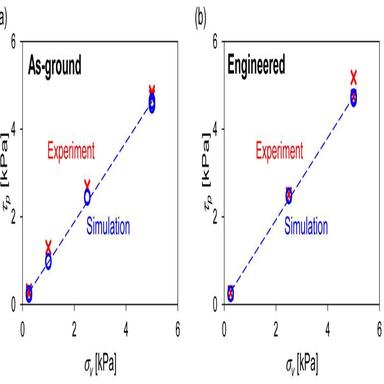
The relation of the peak shear stress τp against the vertical pressure σv from the ring shear test for the two samples. The red 'x's are experimental data, and the blue circles are numerical predictions using the calibrated α.